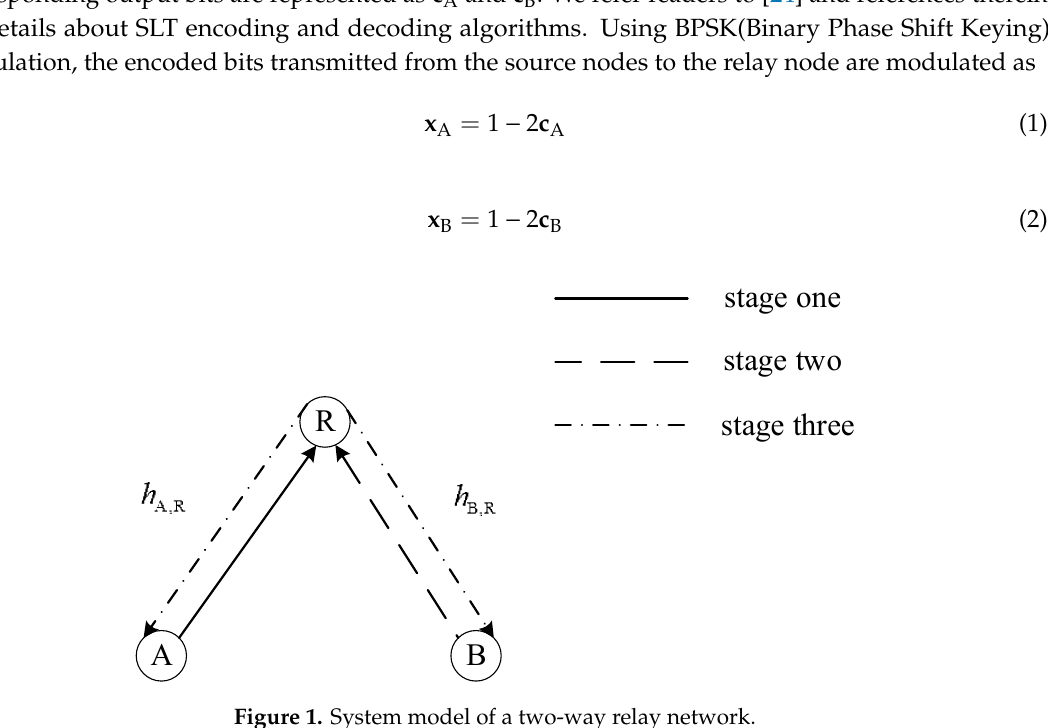
Figure 1. System model of a two-way relay network.